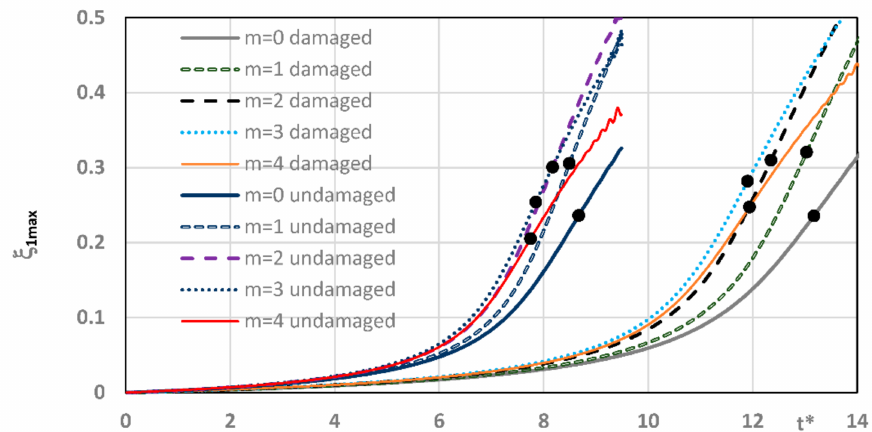
Figure 2. Time histories of deflection of quasi-isotropic FDM plate with health and damaged facings in the form of all cracked fibers.